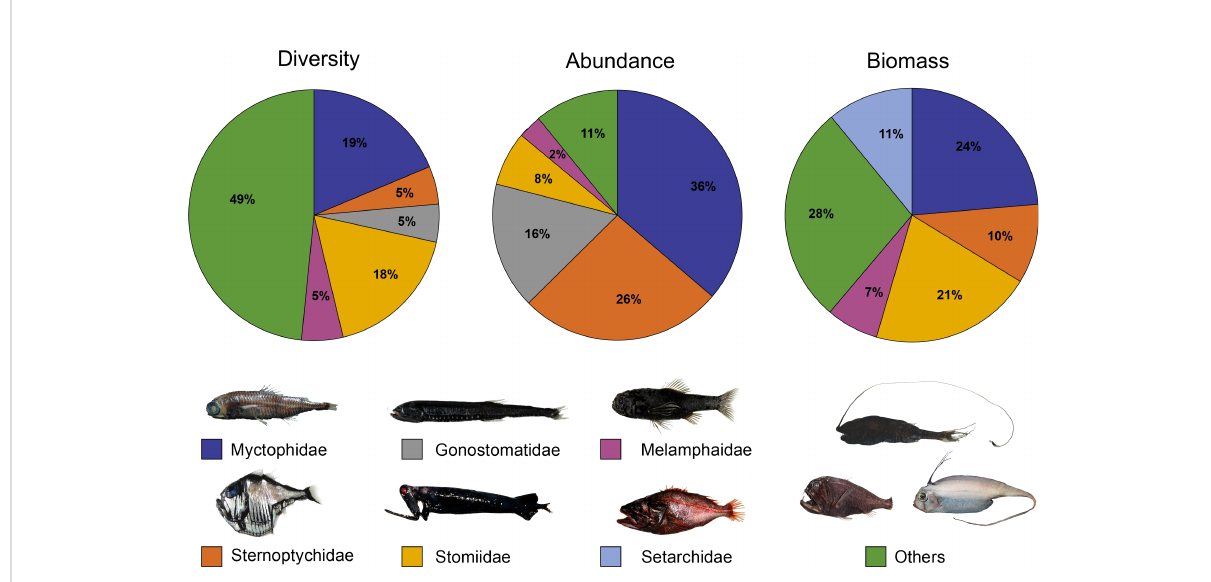
FIGURE 3 Main mesopelagic fi sh families collected on the surveys ABRACOS 1 and ABRACOS 2 when considering diversity, abundance, and biomass. Fish images represent only examples of species included in the